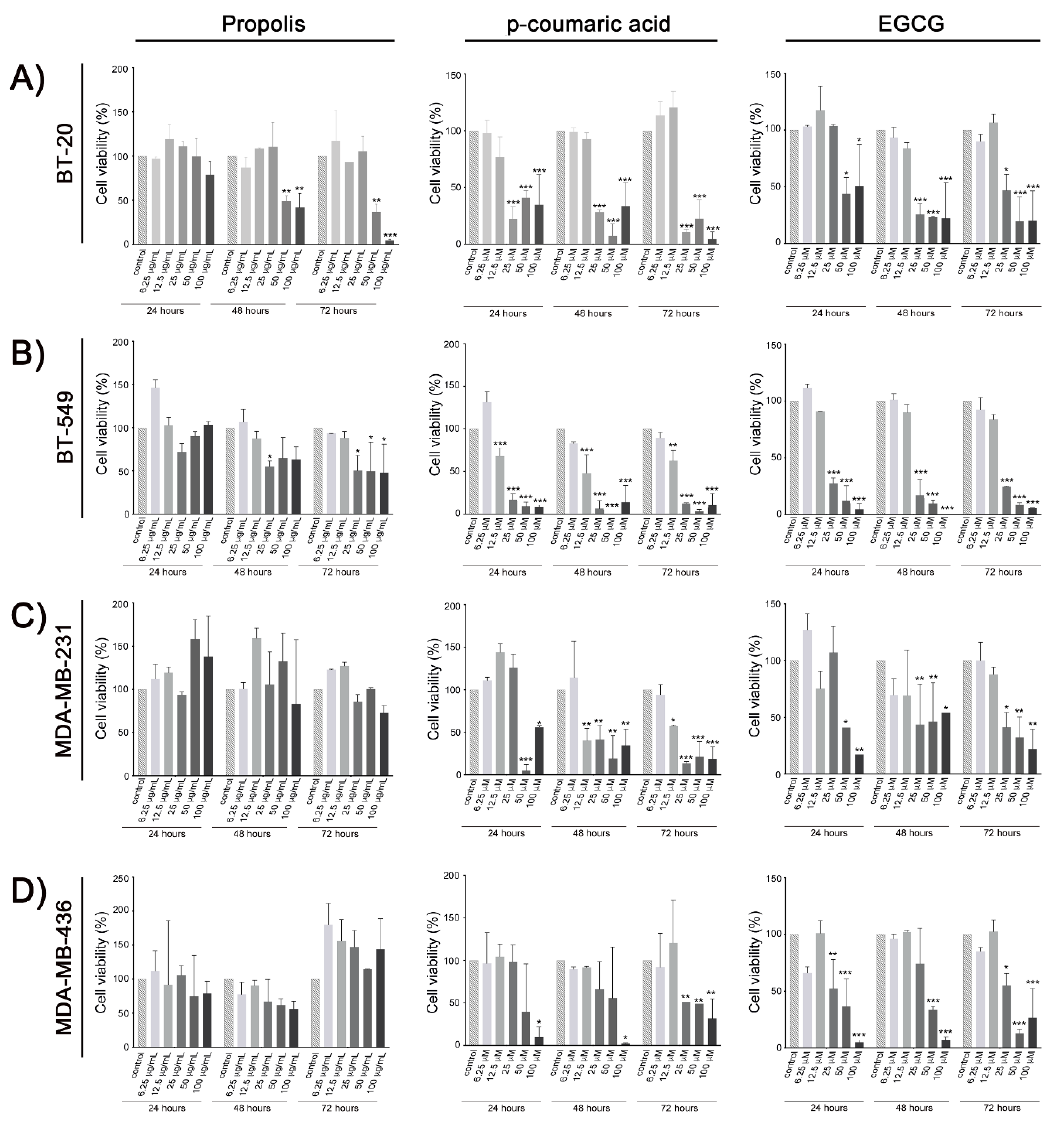
Figure 1. Relative cell viability analysis after in vitro treatment with ethanolic extract of propolis, p -coumaric acid, and ( − )-epigallocatechin-3-gallate (EGCG) in triple-negative breast cancer cell lines: BT-20 ( A ), BT-549 ( B ), MDA-MB-231 ( C ), and MDA-MB-436 ( D ). Data represent means and standard deviation of three independent experiments. * p < 0.05; ** p < 0.002; *** p < 0.001 in comparison with the untreated controls in the respective period of exposure (24, 48 or 72 h).